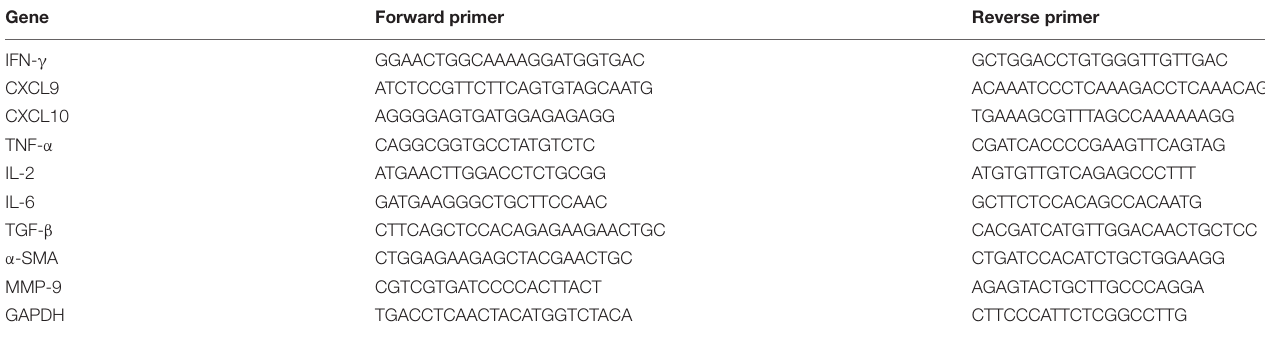
TABLE 1 | Primers for